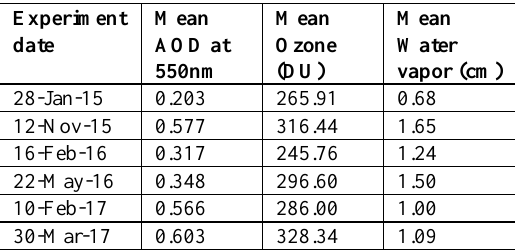
Table 2. List of experiment dates for Resourcesat-2 (RS-2) LISS3 calibration and corresponding atmospheric parameters.